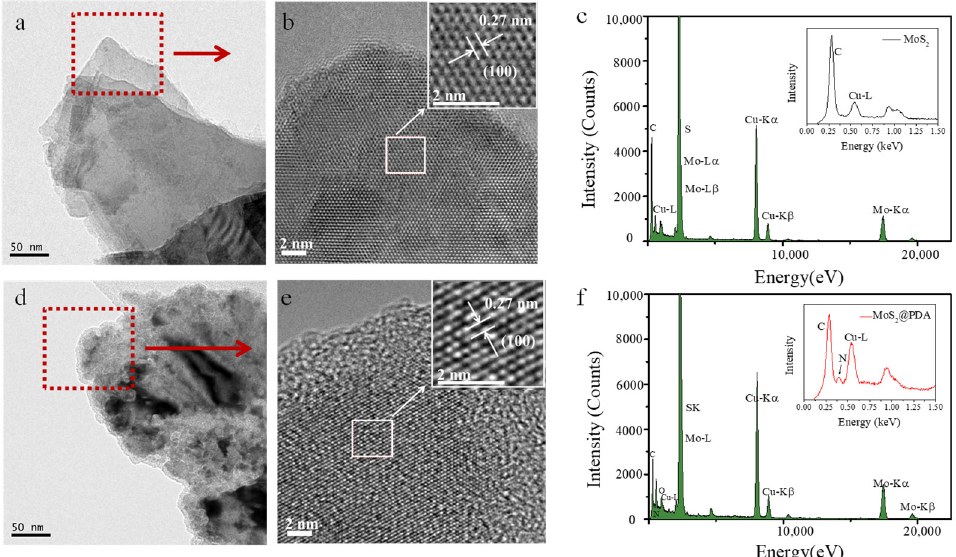
Figure 2. TEM images of MoS 2 ( a , b ) and MoS 2 @PDA ( d , e ), EDS spectrum of MoS 2 ( c ), and MoS 2 @PDA ( f ).